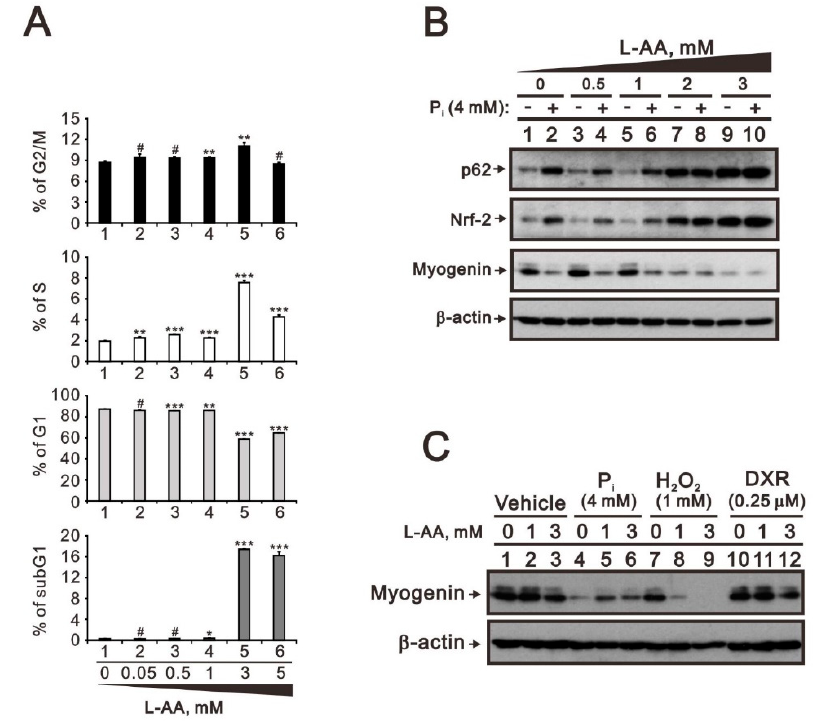
Figure 7. The effects of L-AA on the cell cycle profile and the crosstalk with P i , doxorubicin, and hydrogen peroxide in differentiated C2C12 cells. ( A ) Differentiated C2C12 cells were treated with the indicated concentrations of L-AA for 24 h. The cell cycle profile was analyzed with PI dye. Data are presented as a percentage of the control. Bars depict the mean ± SD. # p > 0.05; * p < 0.05; ** p < 0.01; *** p < 0.001. ( B ) Differentiated C2C12 cells were treated with the indicated concentrations of L-AA combined with 4 mM P i for 24 h. Cell lysates were subject to immunoblot analysis against p62, Nrf2, and myogenin proteins. β -actin was used as loading control. ( C ) Differentiated C2C12 cells were treated with the indicated concentrations of L-AA combined with 4 mM P i , 1mM hydrogen peroxide (H 2 O 2 ), or 0.25 μ M doxorubicin (DXR) for 24 h. Cell lysates were subject to immunoblot analysis against myogenin protein. β -actin was used as loading control.